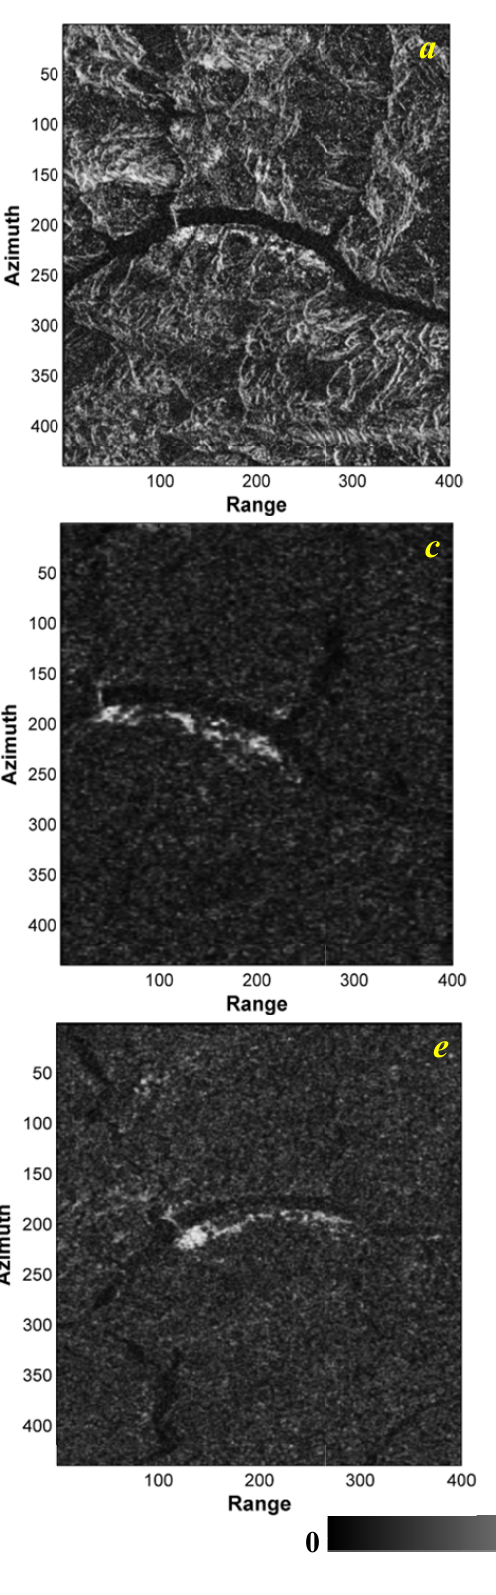
s. 2013 , 5 e 2. Coh etic-Aperturherence im Synthe